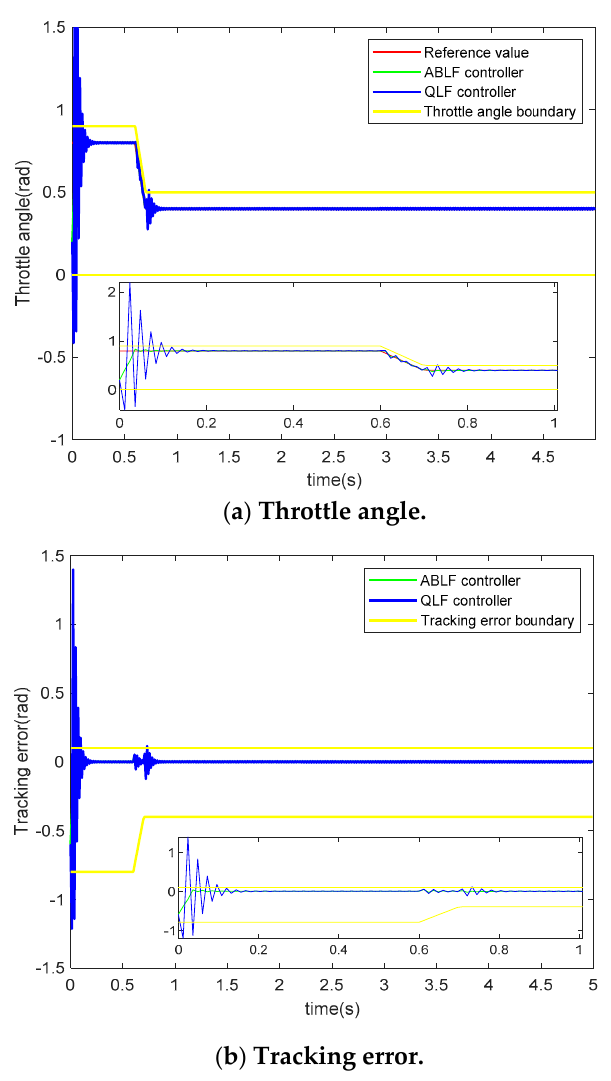
Figure 4. Simulation results under jump signal: ( a ) Throttle angle, ( b ) Tracking error.